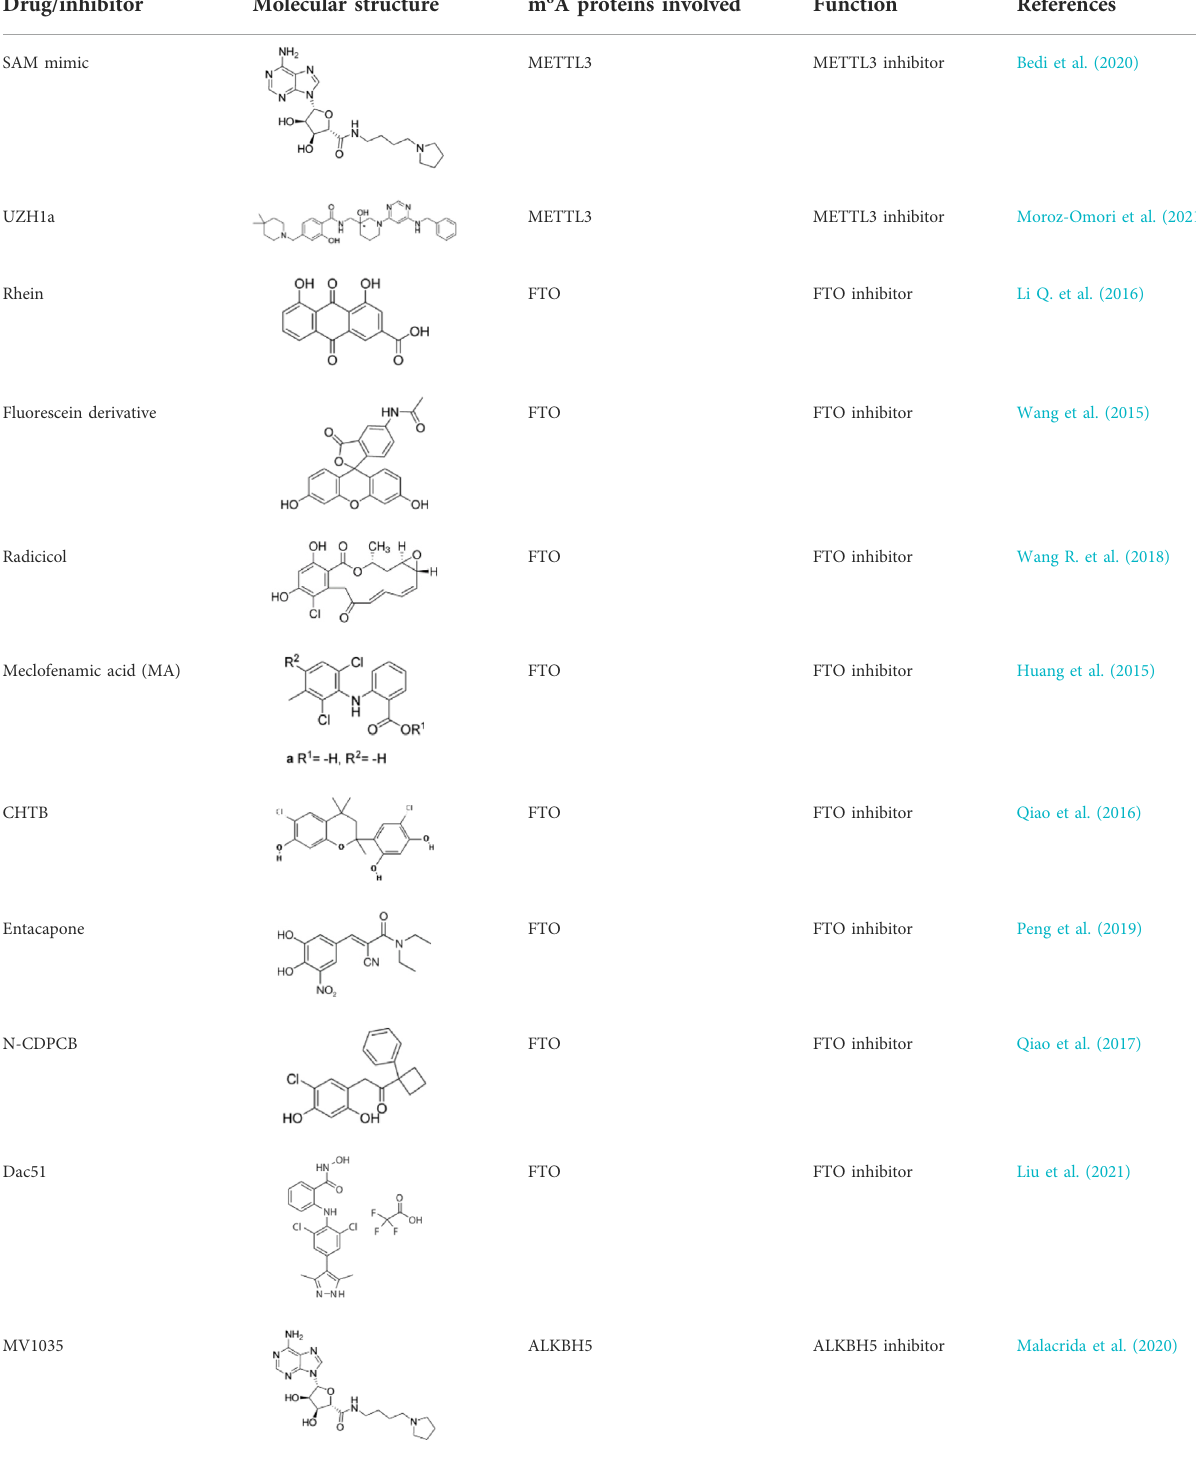
TABLE 2 Overview of the small-molecule drugs and m 6 A-related factor inhibitors described in the